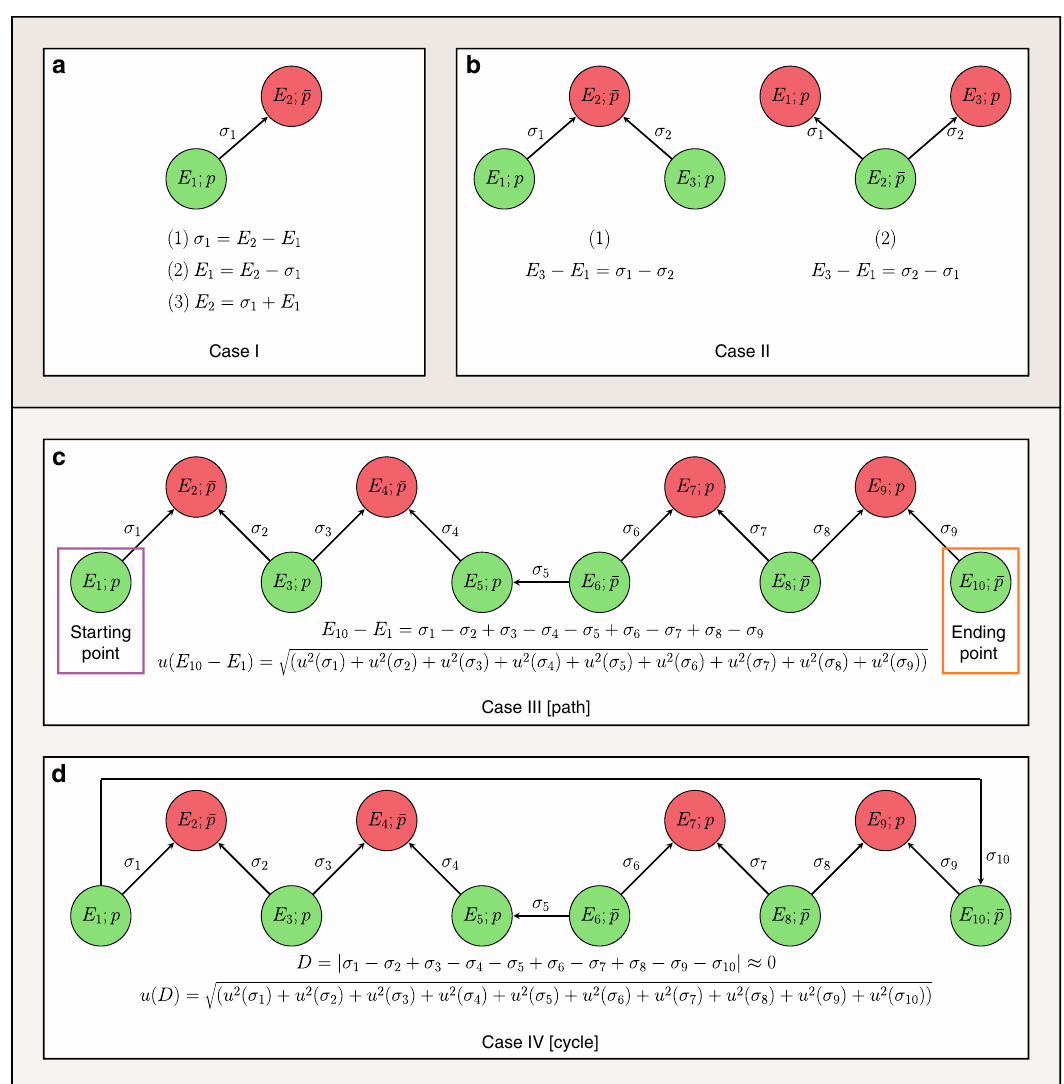
Fig. 1 Graphical illustration of the spectroscopic utilizations of the Ritz principle. In this fi gure, nodes and edges are energy levels and (one-photon, dipole-moment-allowed) transitions with given energy values ( E i ) and wavenumbers ( σ i ), respectively. The parity ( p : even/odd; p : odd/even) is displayed for each rovibronic state. Cases I ( a ) and II ( b ): traditional applications of the Ritz principle, usually called combination differences, where case